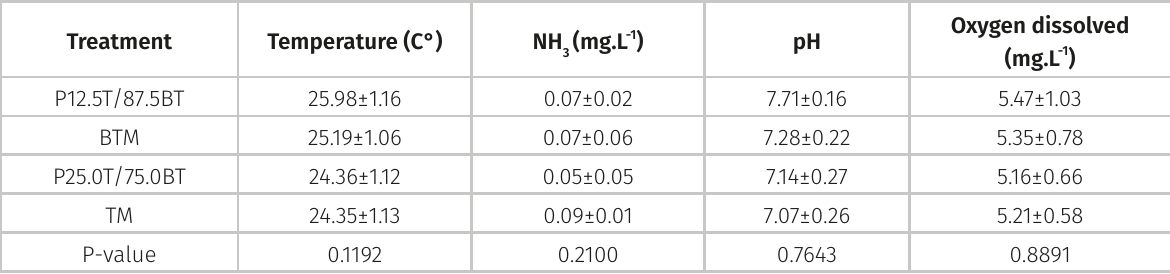
Table III. Water quality of polyculture (P) between bullfrog tadpoles (BT) and Nile tilapia (T), tilapia monoculture (TM) and a bullfrog tadpole monoculture (BTM) experiment 2.